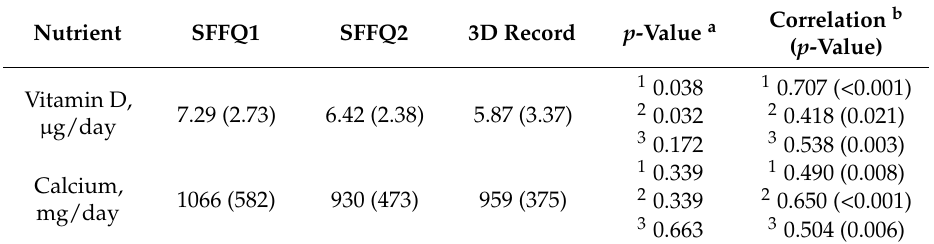
Table 2. Comparison of the mean (SD) daily dietary intake and the correlation of vitamin D and calcium assessment between two short food frequency questionnaires (SFFQ1 and SFFQ2) and a three-day (3D) food record in 28 5–7-year-old children from northern